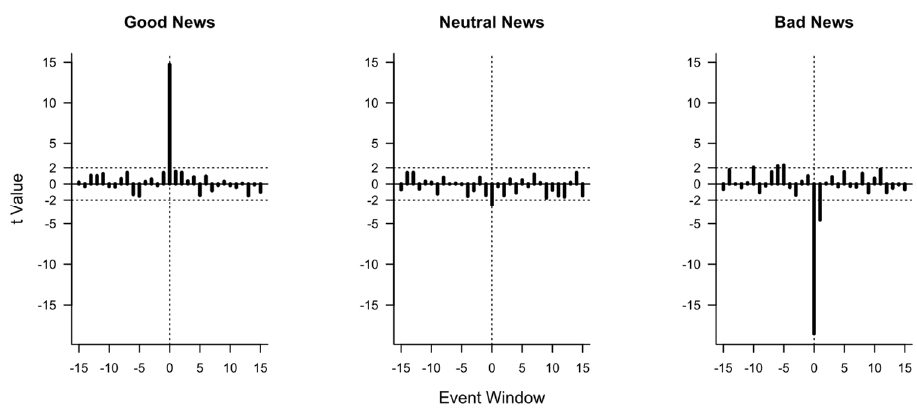
Figure 3. t statistics for the significance of AR t Figure 3. 𝑡 statistics for the significance of 𝐴𝑅(cid:3364)(cid:3364)(cid:3364)(cid:3364) (cid:3047) . Figure 3. 𝑡 statistics for the significance of 𝐴𝑅(cid:3364)(cid:3364)(cid:3364)(cid:3364) (cid:3047) .